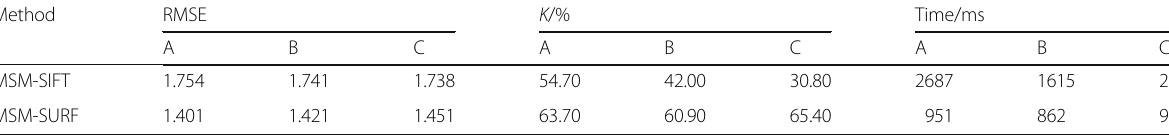
Table 1 Comparison of MSM-SIFT and MSM-SURF methods Method